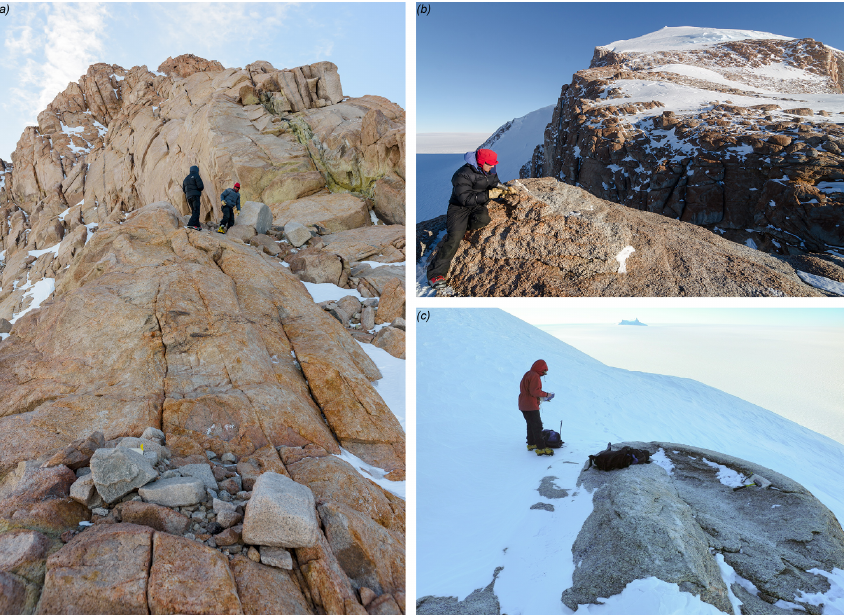
Figure 4. (a) View looking up the steep NE buttress of Mt. Axtell at the Pirrit Hills. The granite ridge crest is generally a few meters wide and oxidized and, in places, displays evidence of exfoliation. In contrast, the glacial deposits, which are visible in the foreground as well as next to the two geologists, are typically only lightly weathered. The boulder with a very flat upper surface in the central foreground is sample 13- NTK-019-PRT. The depositional limit, where sample 13-NTK-013-PRT was collected, is ∼ 15m higher, near the level of the two geologists. (b) View looking up the NW ridge of Mt. Seelig in the Whitmore Mountains. The geologist is collecting sample 13-NTK-041-WHT (236m above the modern ice surface) from the bedrock knob. Other samples come from the narrow ice-free strip of bedrock close to the cliff edge that is visible in the background. (c) Photo of bedrock sample 13-NTK-044-WHT, the highest elevation sample from Mt. Seelig. The sample was collected from an outcrop only a few meters wide that is likely kept ice-free by strong wind near the cliff edge.